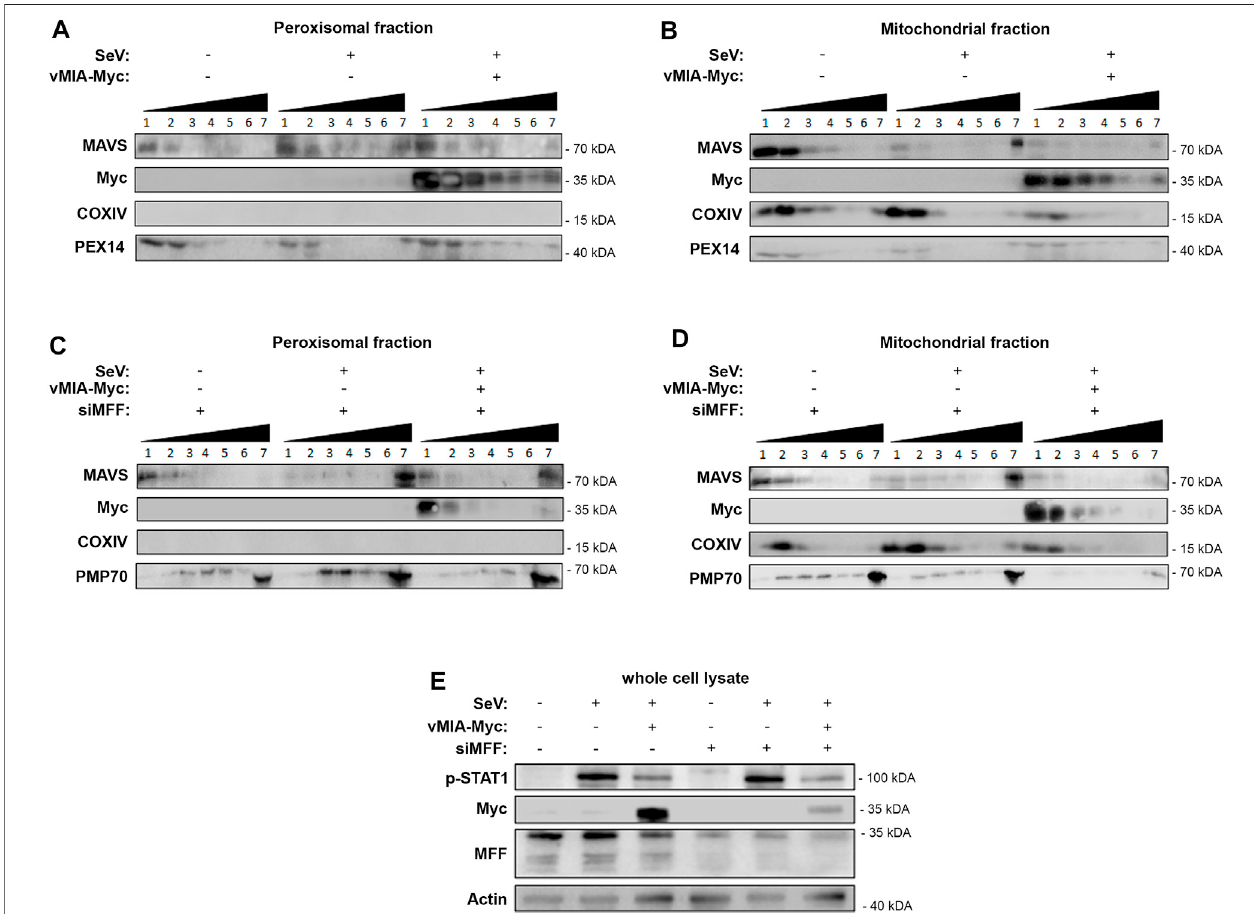
FIGURE 5 | vMIA inhibits MAVS oligomerization at peroxisomes and mitochondria. MFF is essential for the vMIA-mediated inhibition of MAVS oligomerization at peroxisomesbutnotatmitochondria. (A,B) HEK293TcellsinfectedwithSeVinthepresenceorabsenceofvMIA.Densitygradientassaywasperformedtodemonstrate the separation of endogenous MAVS based on its density. 1 — 7 represent the fractions isolated from the gradient assay, where 1 represents the fraction with lowest densityand7representsthefractionwithhighestdensity. (A) Peroxisome-enrichedfraction, (B) Mitochondria-enrichedfraction. (C,D) HEK293Tcellsinfectedwith SeV in the presence or absence of vMIA and in the absence ofMFF. Density gradient assay was performed to demonstrate the separation of endogenous MAVS based onitsdensity.1 — 7representthefractionsisolatedfromthegradientassay,where1representsthefractionwithlowestdensityand7representsthefractionwithhighest density. (C) Peroxisome-enriched fraction, (D) Mitochondria-enriched fraction. (A – D) Immunoblots were performed with antibodies against MAVS, Myc-tag, COXIV, PEX14 and PMP70. (E) Whole cell lysates were resolved by SDS-PAGE. SeV infection, and consequential activation of MAVS downstream signalling, was con fi rmed using anti-p-STAT1. vMIA-Myc overexpression and MFF silencing were also con fi rmed using anti-Myc and anti-MFF, respectively. Antibody against Actin was used as loading control.